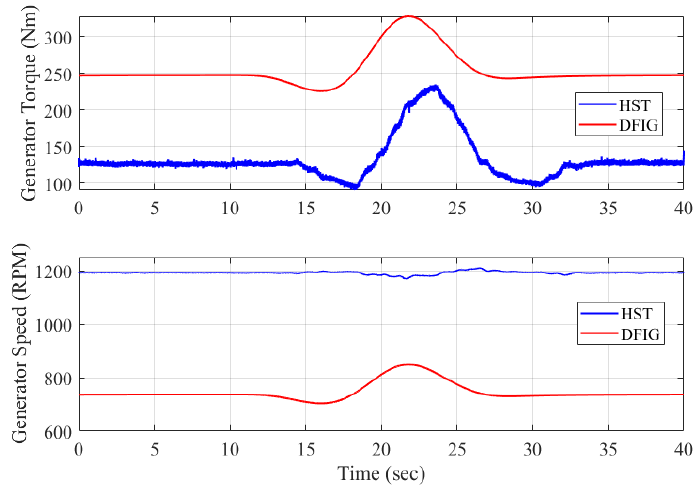
Figure 13. Generator torque and speed to a wind gust.